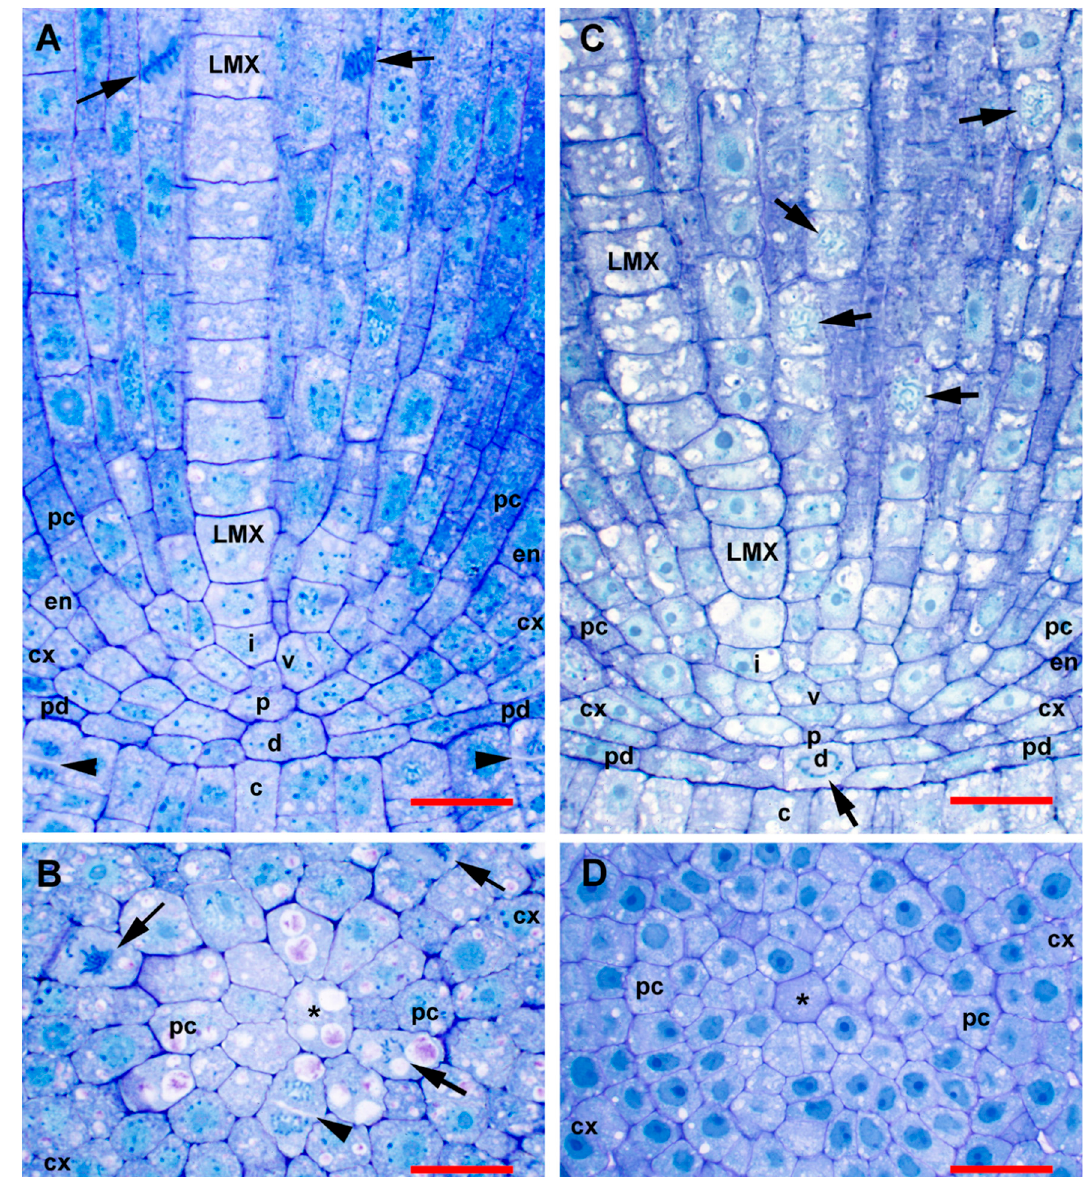
Figure 1. Organization of tissues in the promeristem and primary meristem zones of teosinte and sweetcorn roots at high magnification. Sections were not RNase treated (compare to Figures 2 and 3). ( A ) Slightly off-median longitudinal section of teosinte. ( B ) Transverse section through the plerome of teosinte showing margin initial during cytokinesis. ( C ). Slightly off-median longitudinal section of sweetcorn. ( D ) Transverse section through the plerome of sweetcorn. LMX, late-maturing metaxylem vessel; asterisk (*), plerome central cell; arrow, mitotic cell; arrowhead, newly forming cell plate; c, calyptrogen; cx, immature cortex; d. dermatogen-periblem complex; en, immature endodermis; i, LMX initial cell; p, plerome; pc, pericycle; pd, protoderm; v, vascular initials layer. Scale bar = 25 µm.